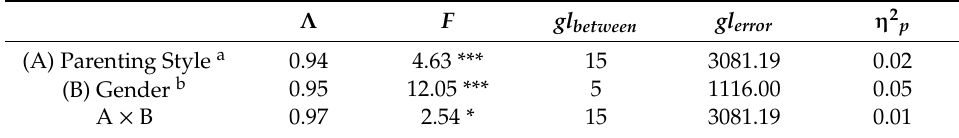
Table 2. MANOVA results for all the studied variables (4 a × 2 b ).